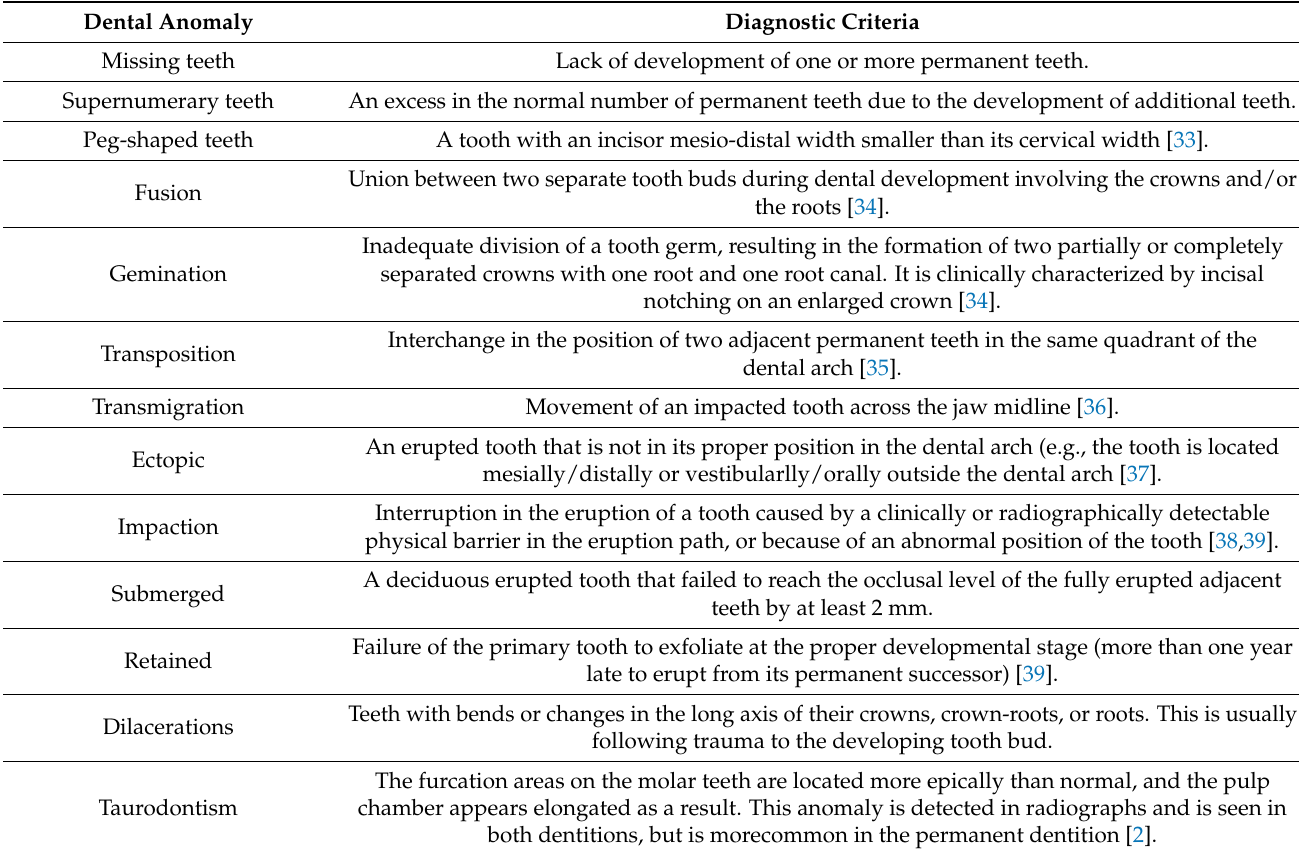
Table 1. Dental anomalies considered in the current study and their diagnostic